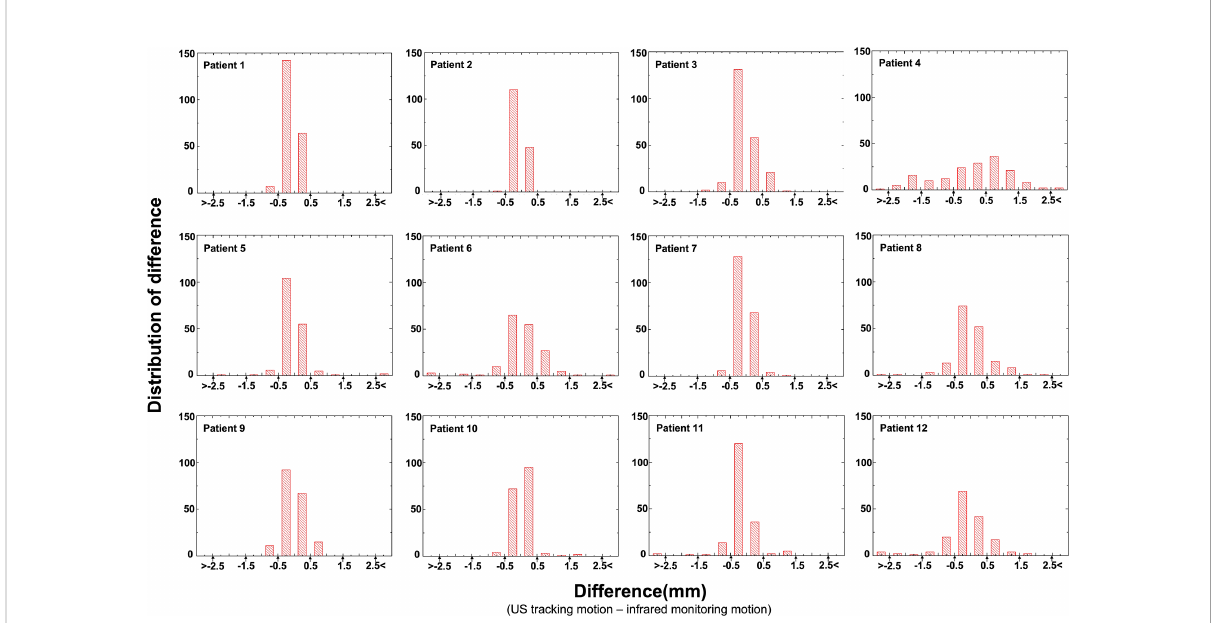
FIGURE 3 The difference (the difference = US tracking displacement – infrared monitoring motion) histogram showed the number of US tracking motions of every